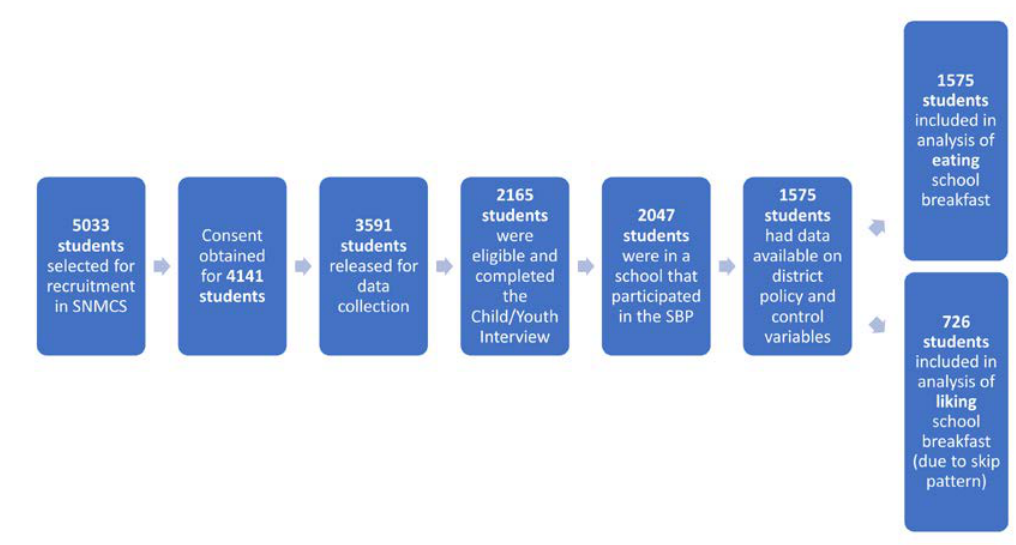
Figure 1. Analytical sample derivation.